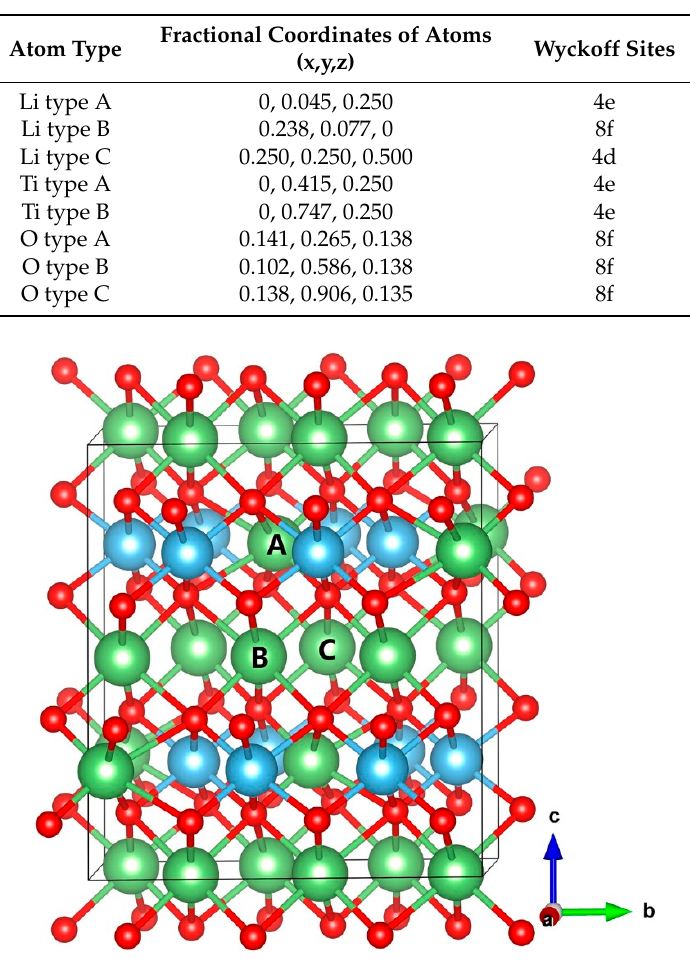
Figure 1. The structure of the β -Li 2 TiO 3 crystal (color online). Lithium atoms are represented by green balls, titanium atoms are blue balls, and oxygen atoms are red balls. The labels of A, B, and C correspond to the three lithium atom positions, respectively.